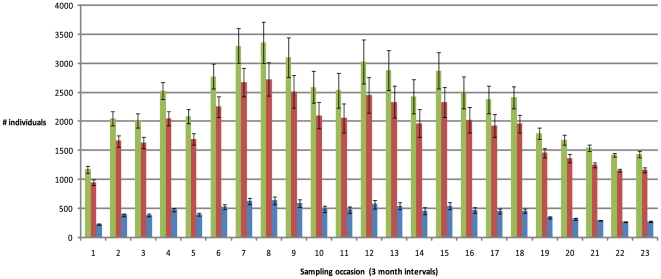
Temporal population estimates for total individuals and total males and females (mature/sub-mature individuals).Estimates of total population (black bars), total males (grey bars) and total females (light bars) for each pooled three-month sampling occasion from the time-dependent model from the capture matrix with sex distinction, . Error bars (1 standard error of the mean) are shown. Mean population estimates over the entire sampling period are 2344 individual mature/sub-mature Nautilus (95% CI = 1117 to 3570; SD = 626); 1900 males (95% CI = 906 to 2896; SD = 508) and 443 females (95% CI = 211 to 675; SD = 118).